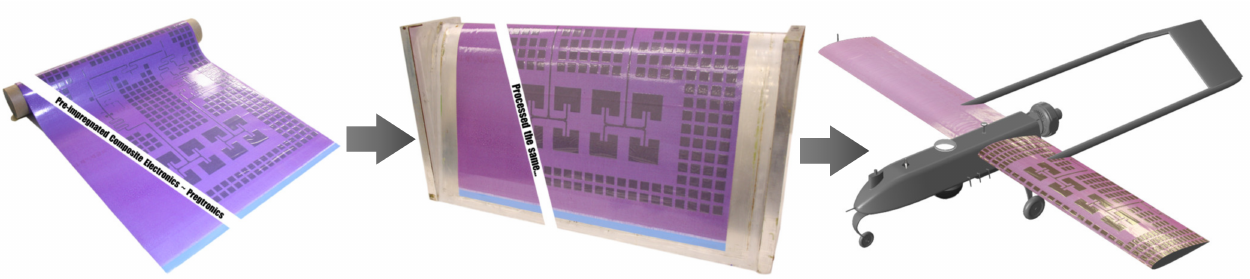
Figure 1. CLAS concept. Prepreg composite material with embedded electromagnetic traces can be cured in aerospace composite structures, such as wing skins on